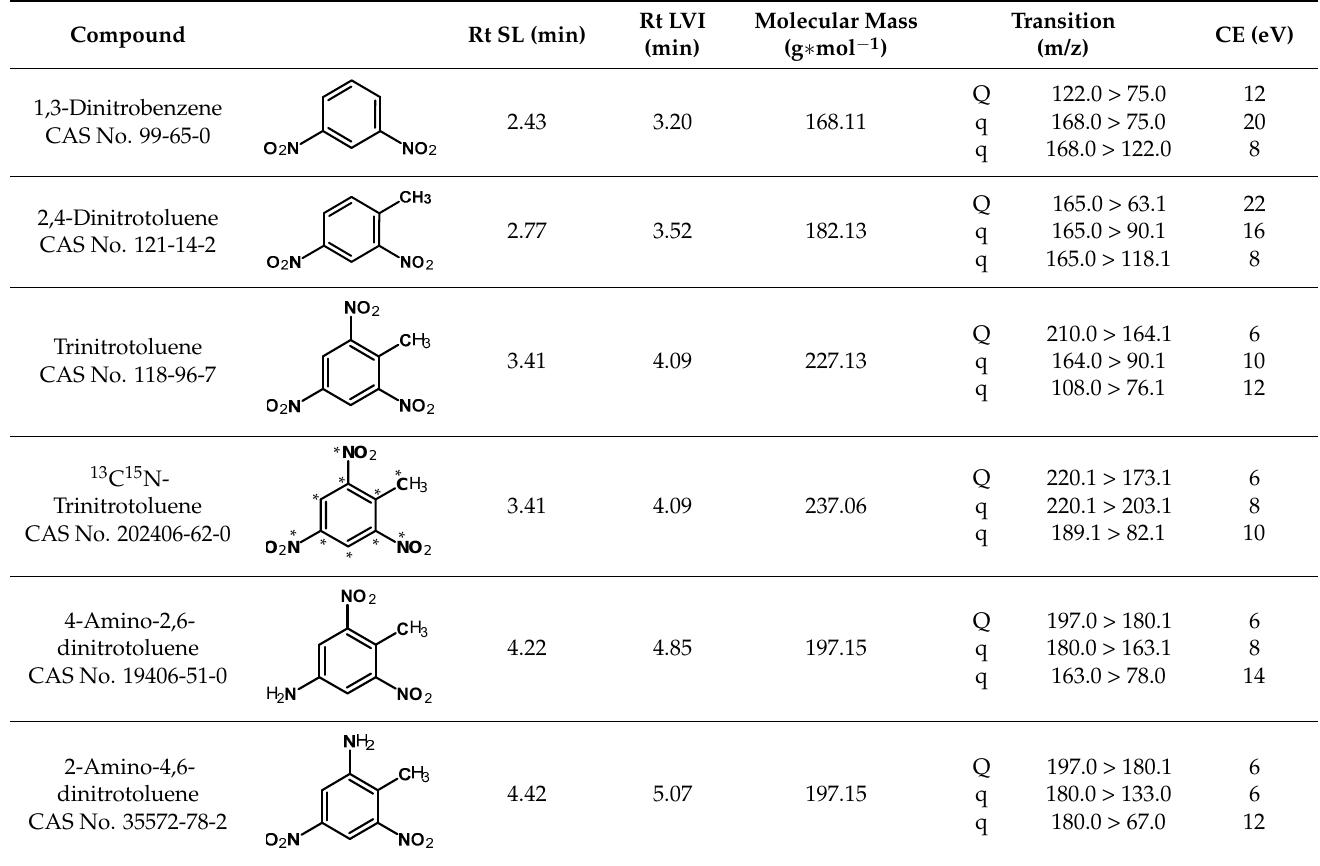
Table 1. GC retention times and MS/MS transitions for the energetic compounds examined. Adapted from Bünning et al. 2021 [47].